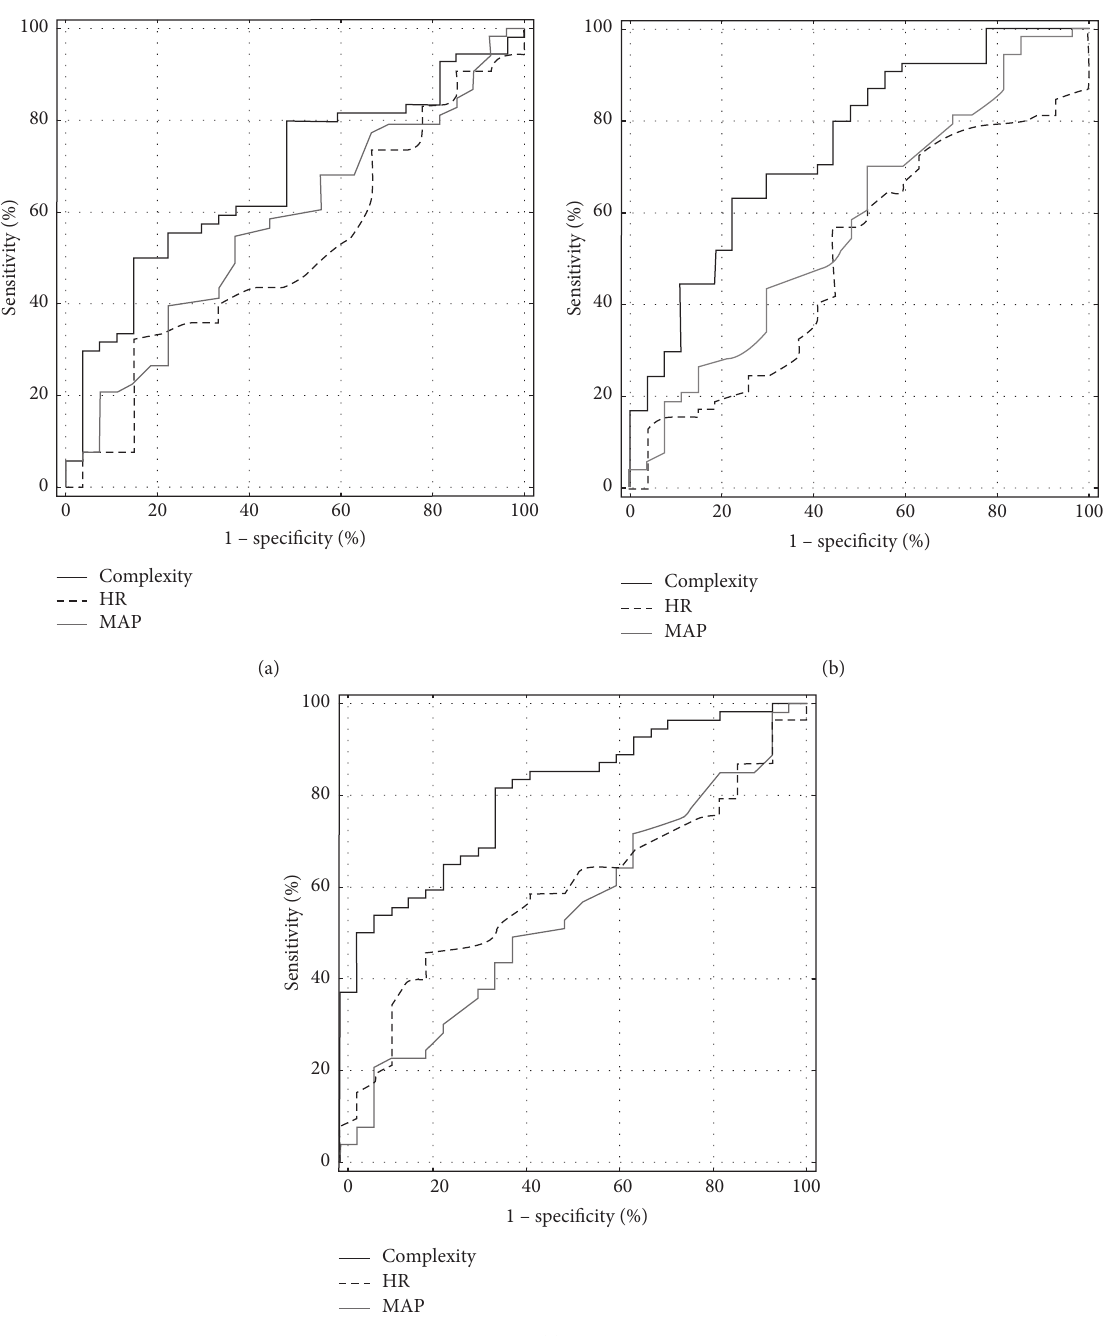
Figure 4: Comparison of ROC curves of complexity, mean arterial pressure (MAP) and heart rate (HR) for the chosen time points: 180s (a), 120s (b), and 60s (c) before the termination of